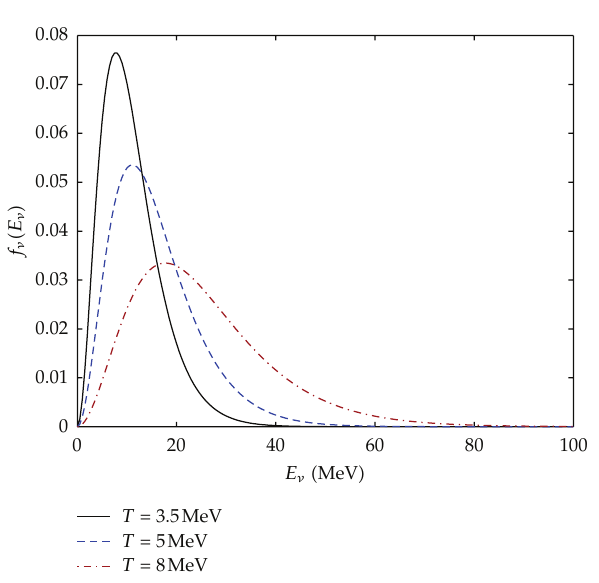
Figure 2: (cid:3) Color on line (cid:4) . The normalized to unity Fermi-Dirac spectrum for α (cid:8)